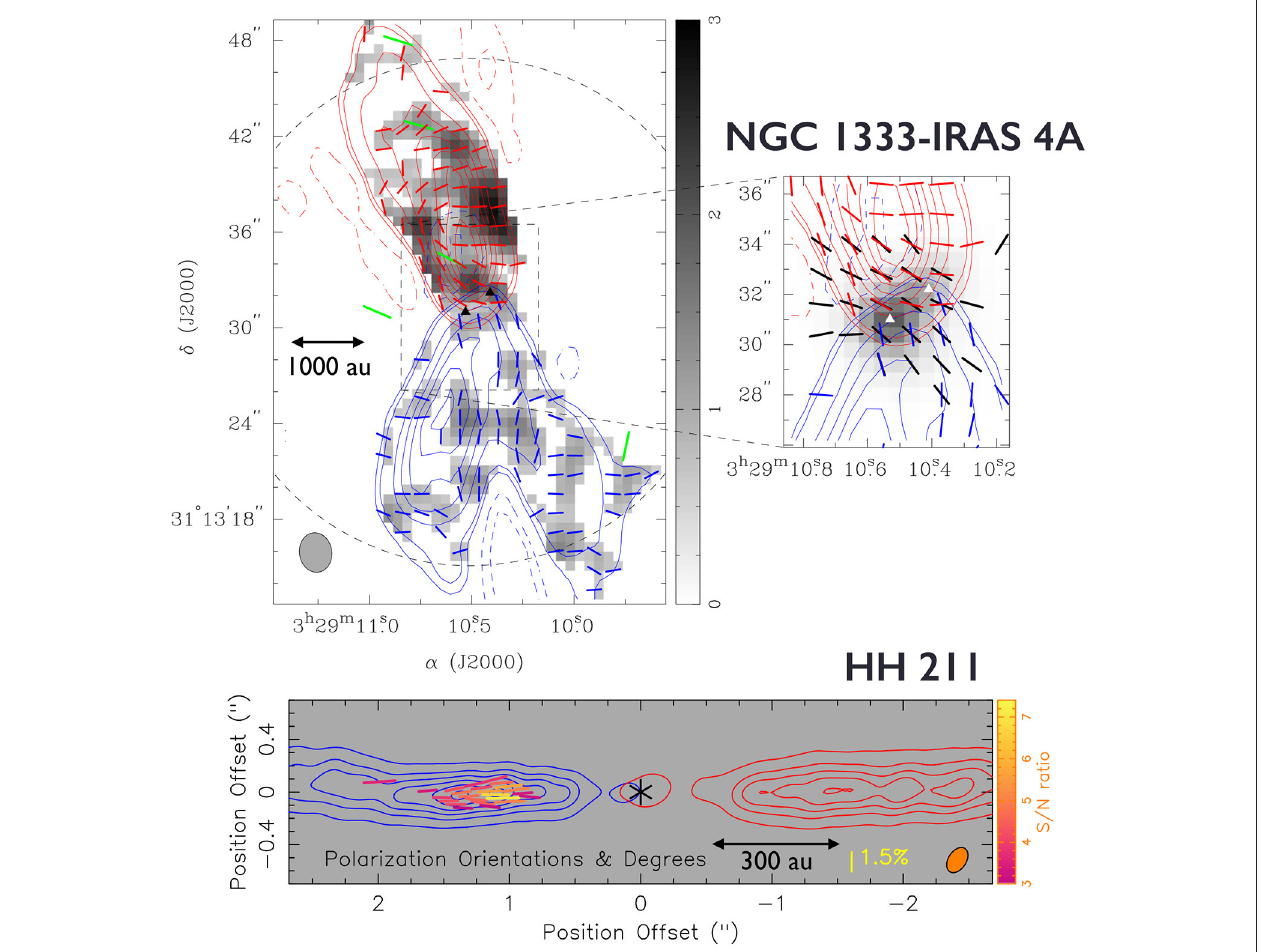
FIGURE 5 | Observations of spectral-line polarization from the G-K effect toward bipolar outflows from low-mass protostellar sources. (Top left) SMA observations of polarization of the CO( J 3 2) line (red and blue line segments) toward NGC 1333-IRAS 4A, adapted from Ching et al. (2016). The grayscale shows the = → CO( J 3 2) polarized intensity in units of Jybeam − 1 kms − 1 . The authors also compare with CO( J = → plotted in green. (Top right) Comparison of the SMA CO polarization data with the 870 µ m dust polarization map (the black line segments have been rotated by 90 ◦ to reflect the inferred magnetic field direction). (Bottom) SMA observations of polarization in the SiO( J line segments indicate different levels of significance in the polarized intensity; the lengths of the segments are scaled to the polarization fraction. The top panel was reproduced with permission from the AAS. The bottom panel was reproduced, with modifications, in accordance with the Creative Commons Attribution 4.0 International License ( creativecommons.org/licenses/by/4.0